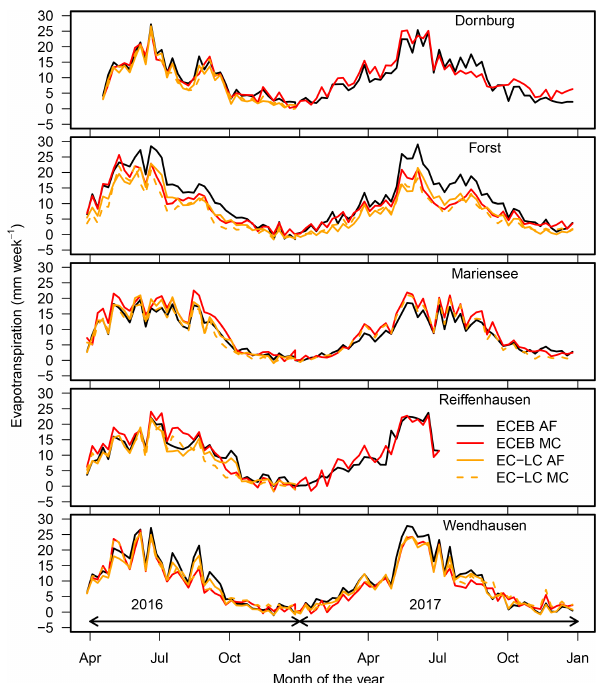
Figure 9. Weekly sum of half-hourly ET ECEB (black and red solid lines for AF and MC, respectively) and ET EC-LC (orange solid and dashed lines for AF and MC, respectively) for all sites. In 2017, data in Reiffenhausen AF and MC were only available until the end of July due to station failure.